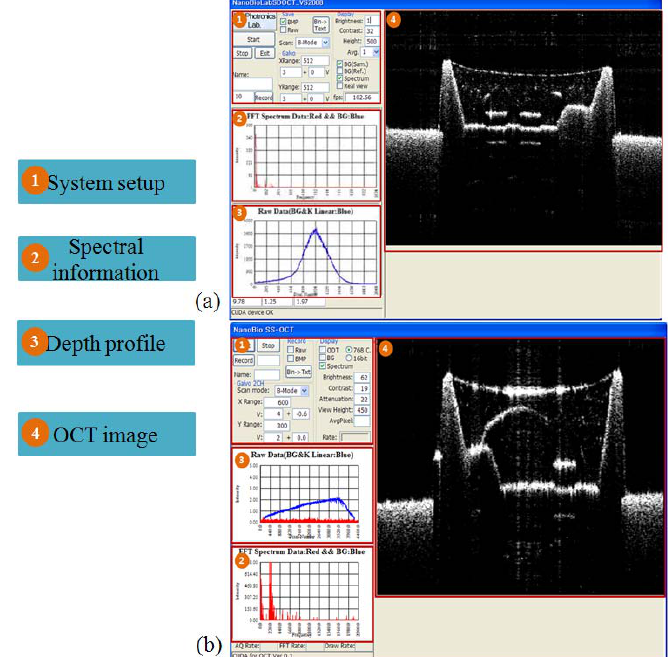
Figure 5. Program UI. ( a ) 840 nm SD-OCT program UI; ( b ) 1,310 nm SS-OCT program